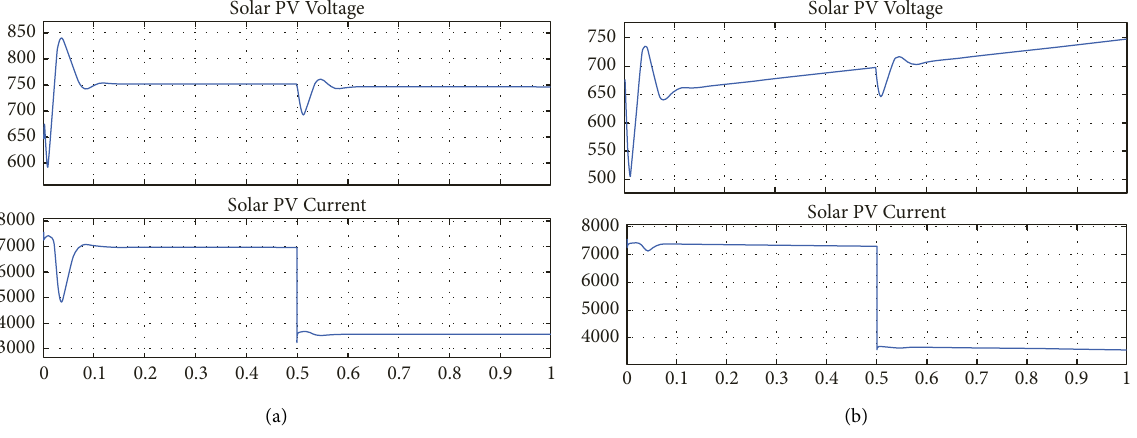
Figure 16: Voltage and current output. (a) ANN-PSO. (b) PO.